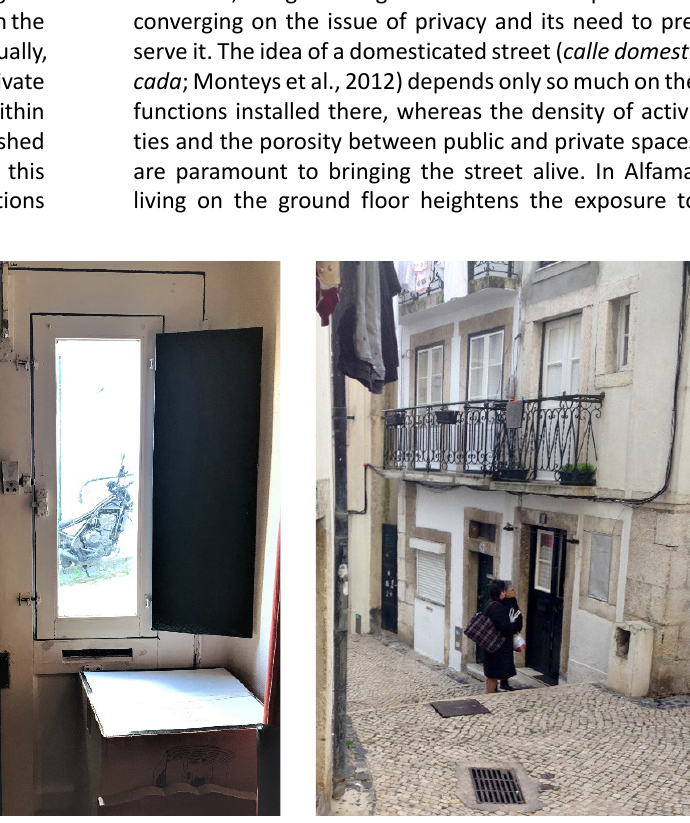
Figure 1. Door wicket and threshold, Figure 2. Door wicket, Alfama, Figure 3. Neighbors talking through a February 2019. door wicket, Alfama, January